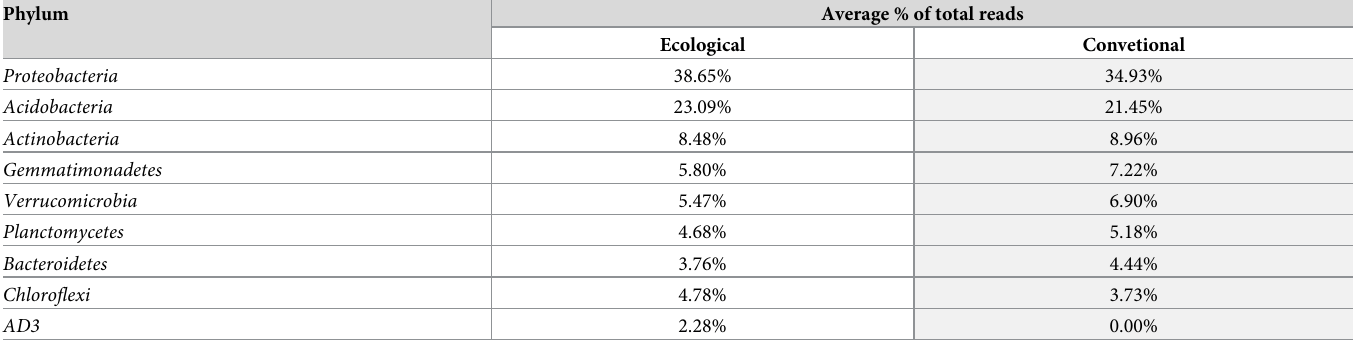
Table 3. The average relative abundance of bacteria at the phylum level in all samples (the table presents only the top 10 microbial phyla in relative abundance, rep- resenting more than 2% of the total readings).